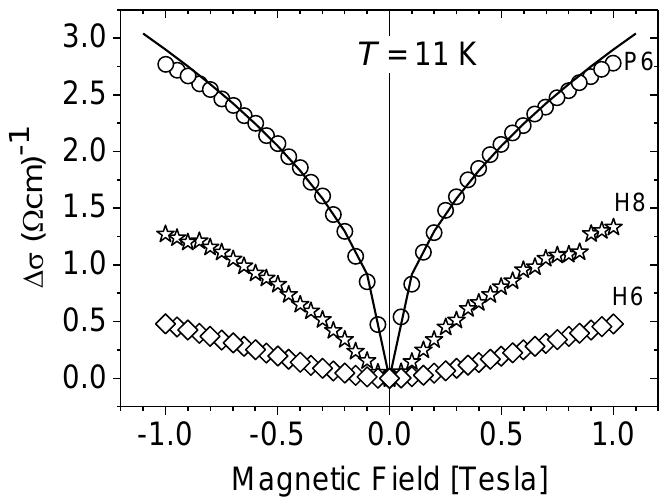
Figure 3. ∆ σ vs. magnetic field B . Results at T = 11 K for samples with different, increasing carrier concentration: - n H = 3.1 × 10 18 cm − 3 (diamonds, sample H6); - n H = 1.1 × 10 19 cm − 3 (stars, sample H8); - n H = 1.2 × 10 20 cm − 3 (circles, sample P6). Solid line—Kawabata’s universal Equation (3).